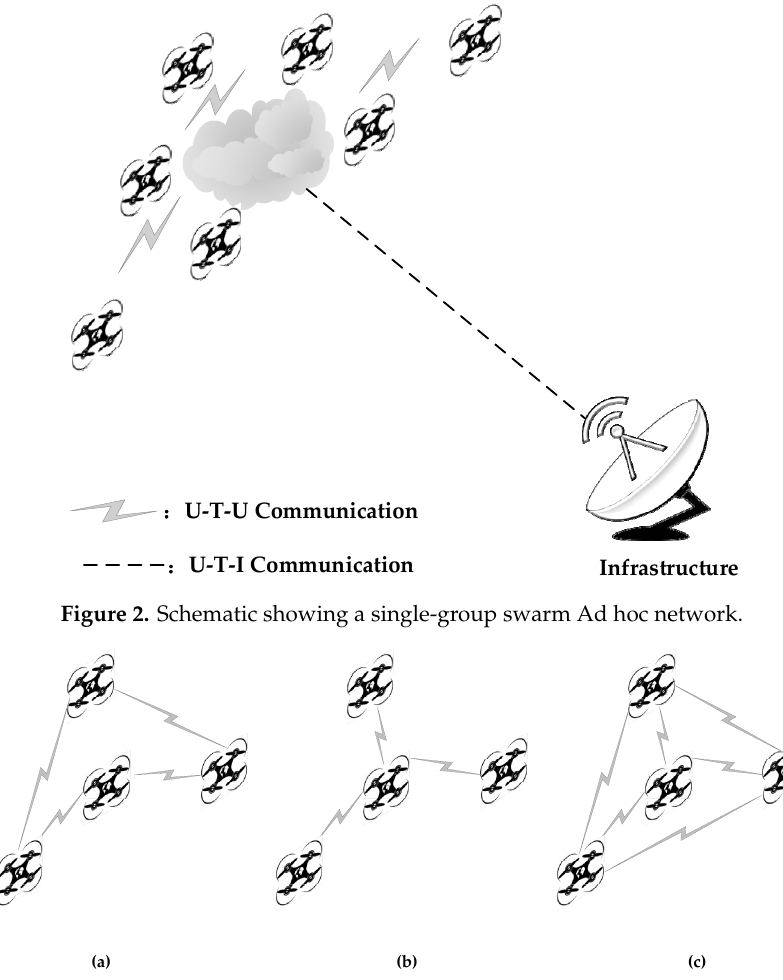
Figure 3. Intra-swarm communication architecture: ( a ) ring architecture, ( b ) star architecture, ( c ) meshed architecture.